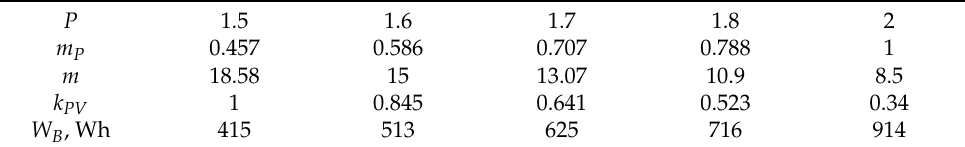
Table 3. Calc ending on ρ .